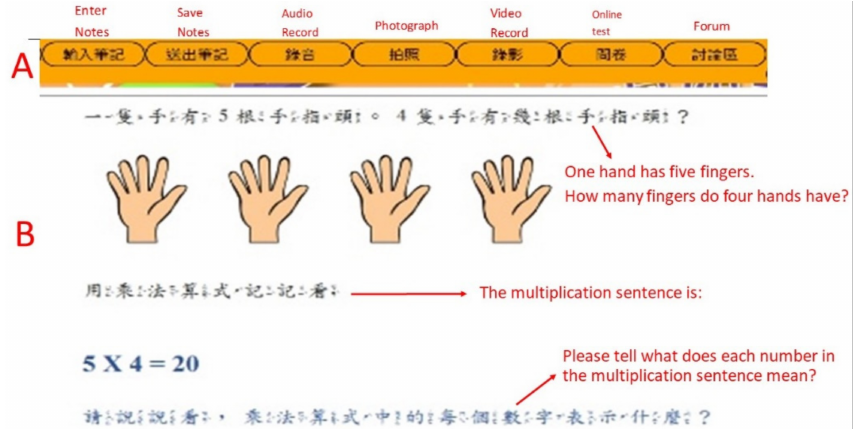
Figure 2. Student is reading the digital content of the MLS. ( A ) Function bar of MLS. ( B ) The learning materials are presented here.